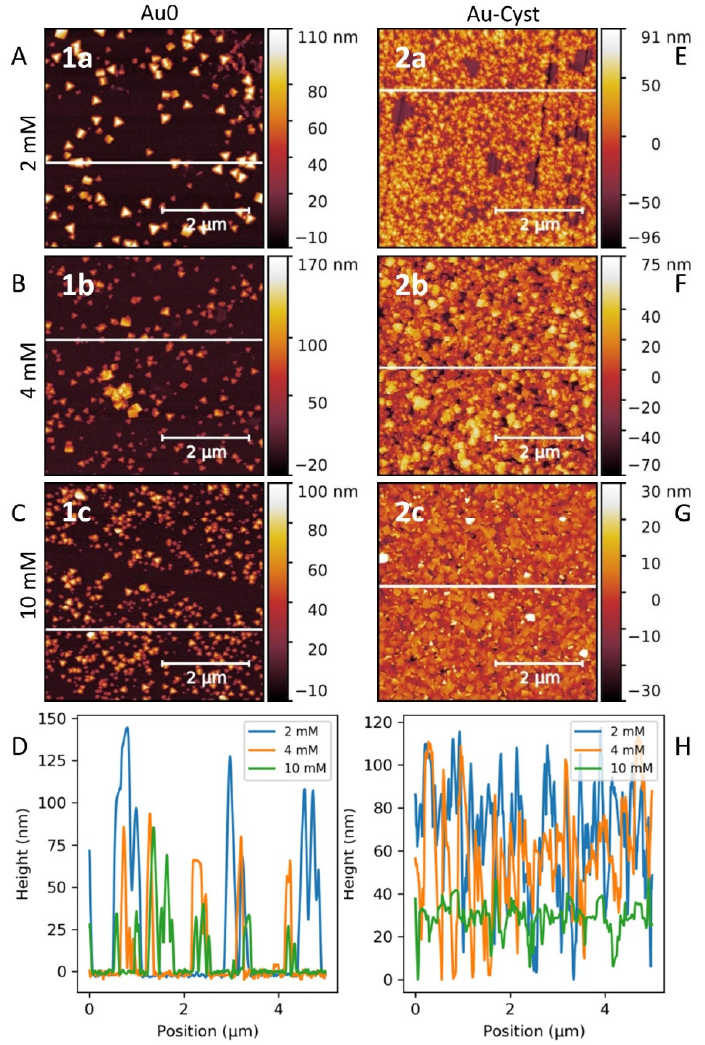
Figure 3. AFM images ( A – C , E – G ) for samples 1a–c–2a–c corresponding to the growth on bare gold and cysteamine-functionalized gold surfaces with different precursors at concentrations of 2 mM (1a, 2a), 4 mM (1b, 2b), and 10 mM (1c, 2c) and the corresponding height profiles ( D,H ). PB growth on cysteamine-functionalized gold surface indicates two important ef- fects: (i) the almost total and homogeneous covering of the gold surface with the PB nano- objects and (ii) the observed impact of the reactants′ concentration on the shape of the